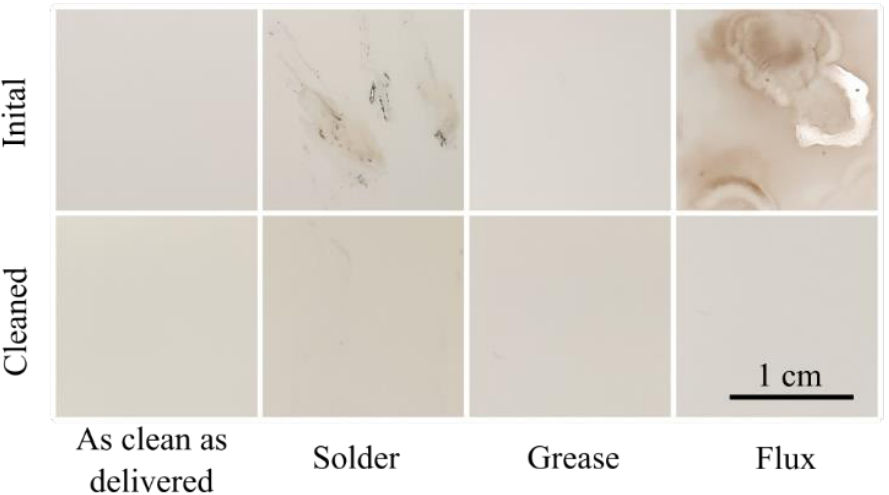
Figure 2. Visual comparison of the ceramic substrates before and after performing the cleaning procedure. The procedure was performed on “as clean as delivered” samples as well as on samples with solder, grease and flux contaminations.